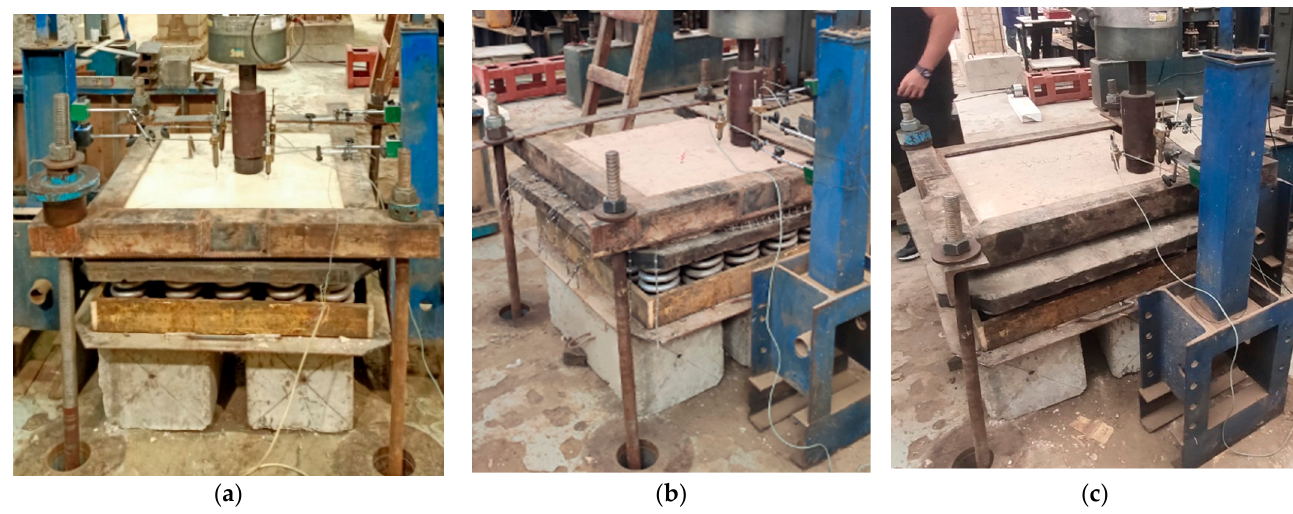
Figure 5. Test set-up for the three load cases: ( a ) Interior; ( b ) Edge; ( c ) Corner. The parameters measured during the monotonic testing were the slab vertical deflec- tion and the applied load. The deflection that occurred at the loaded area was measured by linear variable displacement transducers (LVDTs). The maximum applied load which caused the collapse of the slab was defined as the ultimate load carrying capacity. The load versus deflection curves were plotted for different loading positions for each